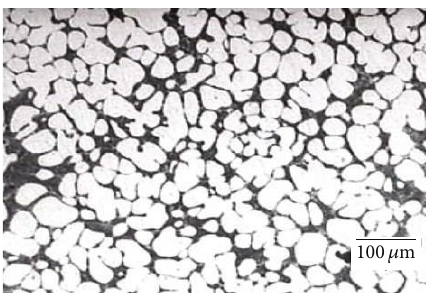
Figure 15: Microstructure of A356 aluminum at 620 ∘ C obtained by the cooling slope technique